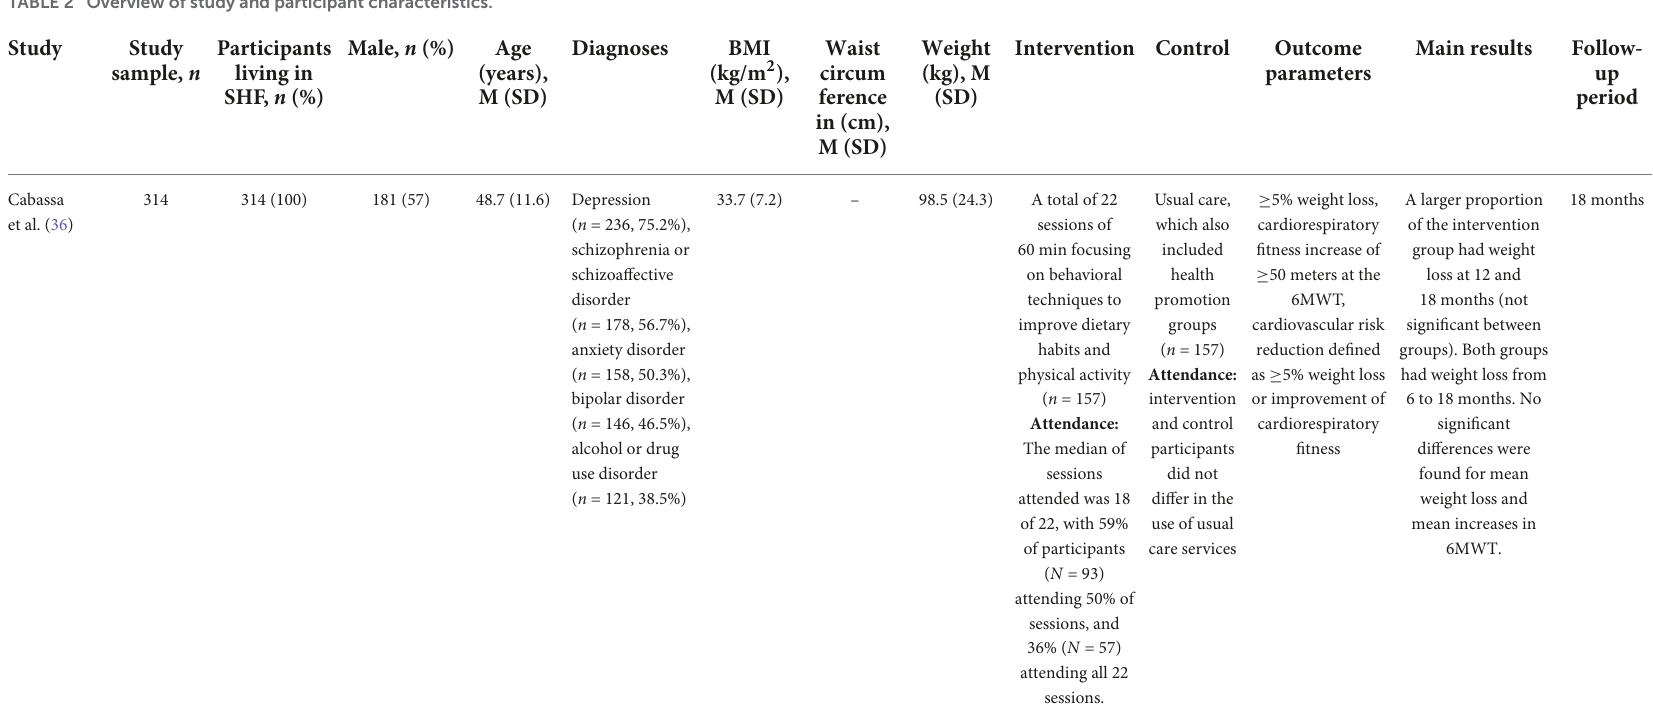
Main results Follow-